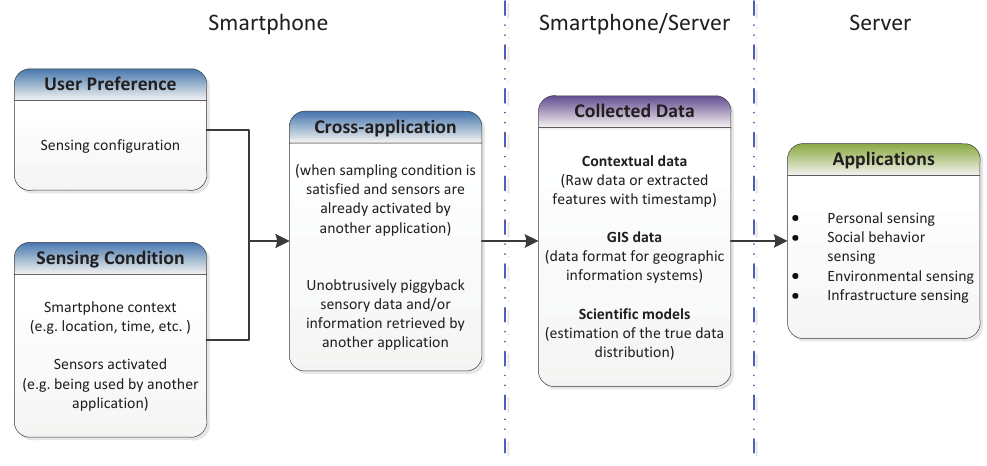
Figure 4. Common architecture for symbiotic